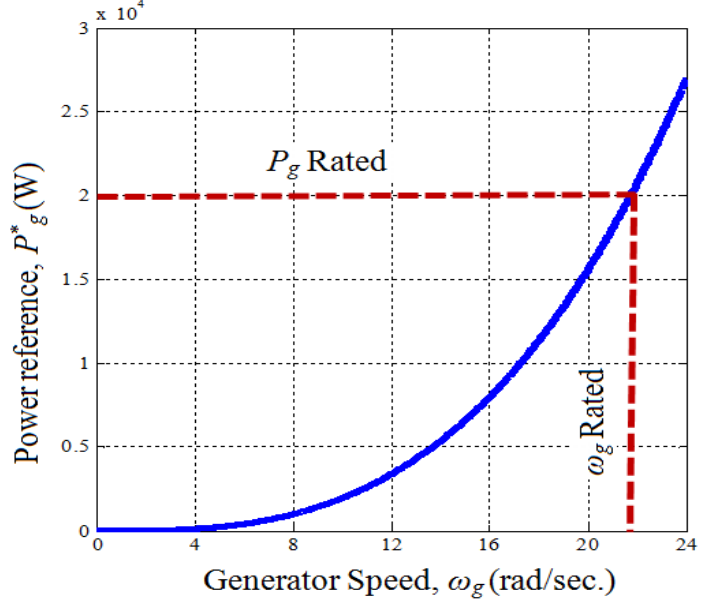
Figure 6. Generator power reference versus generator